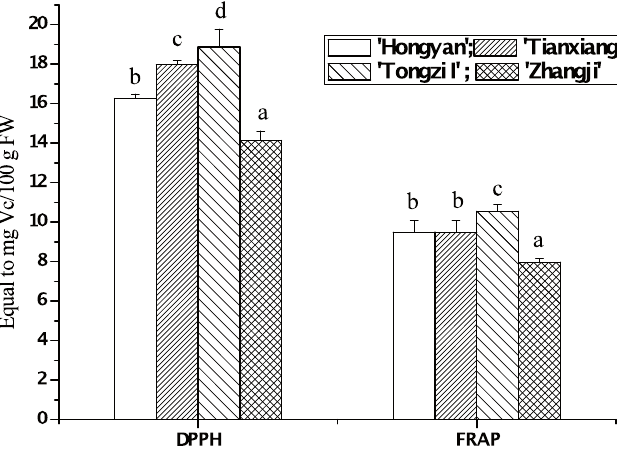
Fig. 2: ·DPPH and FRAP values in selected four cultivars of strawberries. Enzyme activity